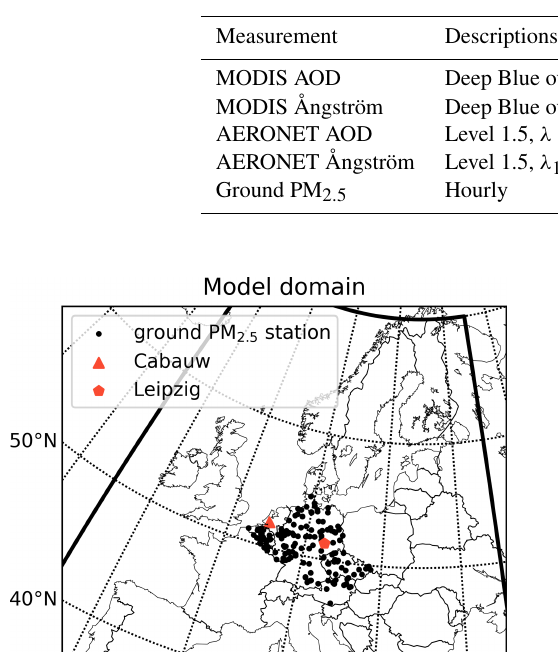
Table 3. Measurements for assimilation and validation.